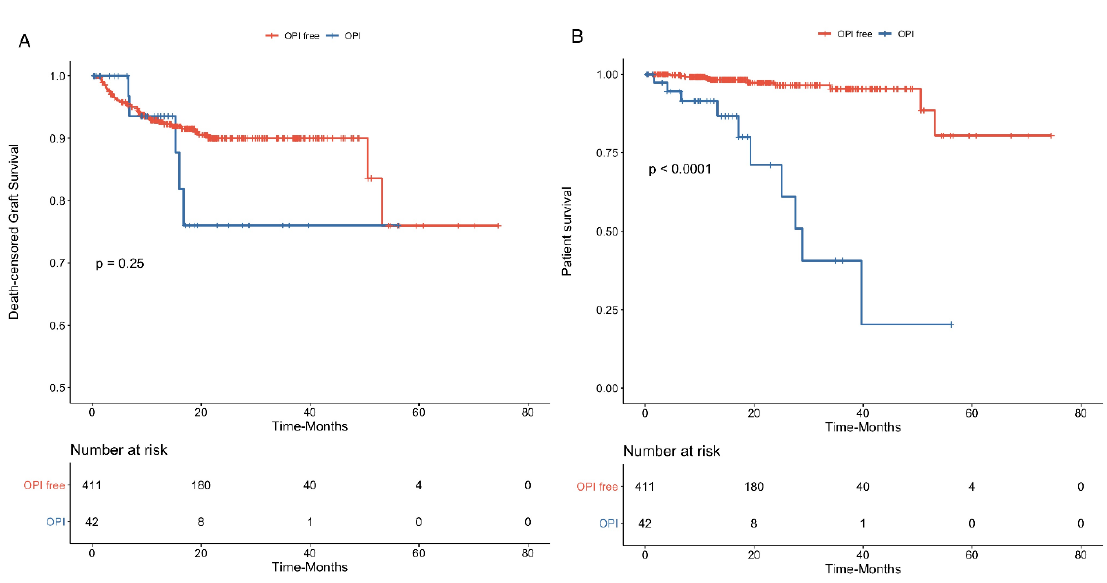
Figure 2. Early conversion to belatacept as a risk factor for an opportunistic infection (OPI). Kaplan– Meier analysis curve of OPI-free survival in kidney transplant recipients converted earlier (<6- months) and later (≥6-months) to belatacept ( A ) and of recipients converted to belatacept before <8- months and after ≥8-months ( B ).